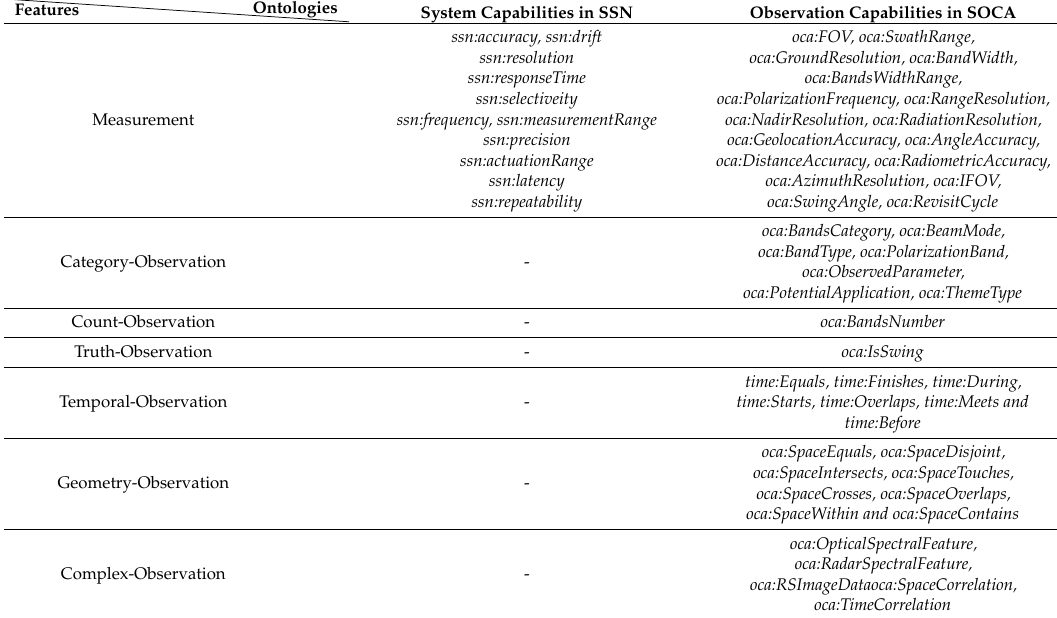
Table 2. Comparison between the SOCA and SSN